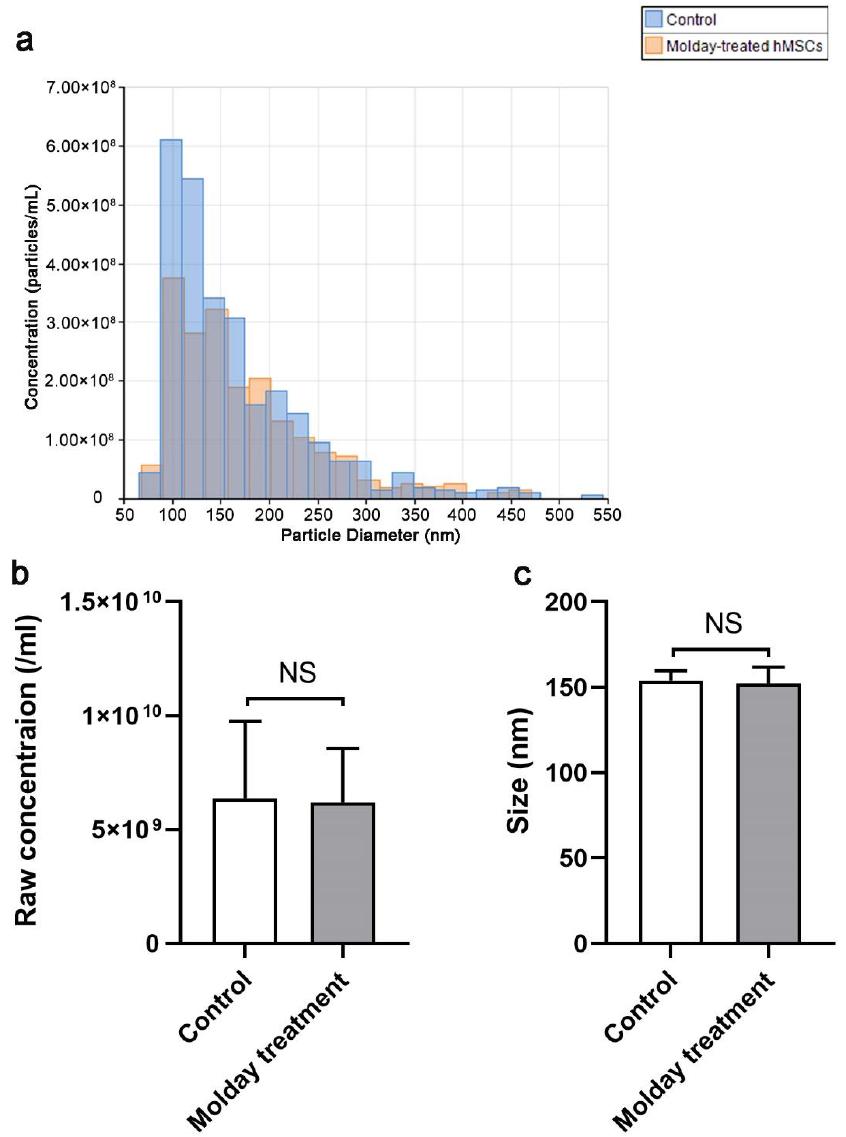
Figure 2. Size distribution, concentration, and size comparison of EVs derived from Molday ION- treated and control hMSC: ( a ) Size distribution of EVs derived from Molday ION-treated and control hMSC. ( b , c ) Concentration and size comparison of EVs derived from Molday ION-treated and control hMSC. NS: No significant difference between treatment groups.